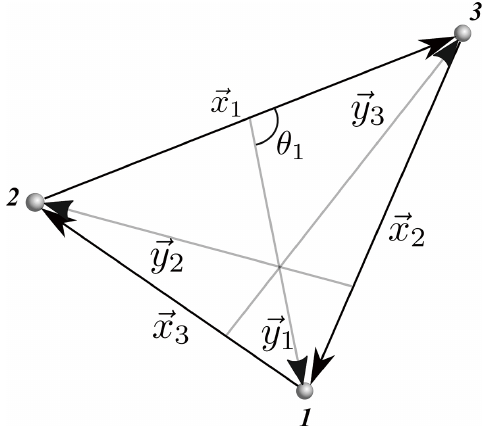
Figure 1. Jacobi coordinates for three